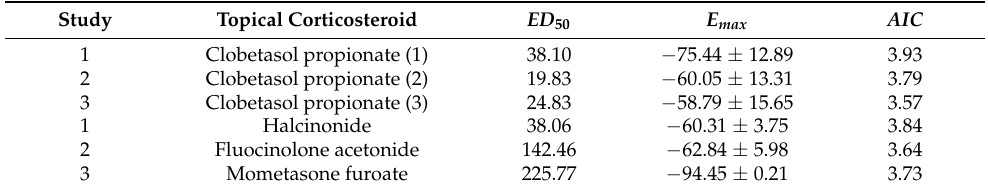
Table 1. Summary of population model